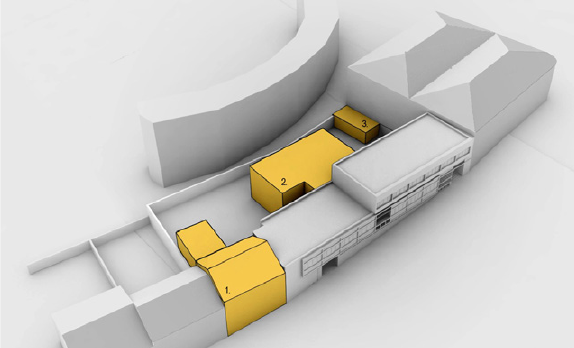
Figure 8. Existing volumes in Abade Loureira